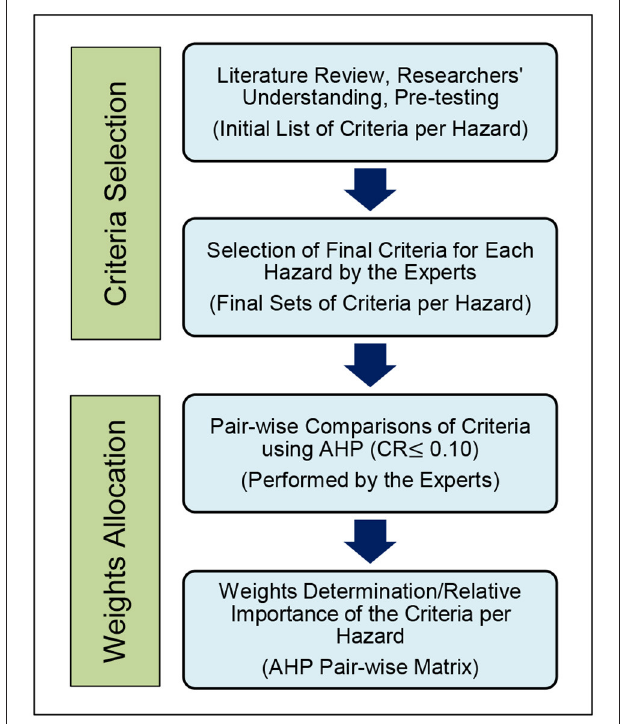
FIGURE 1 | Overall flow of criteria establishment per hazard.